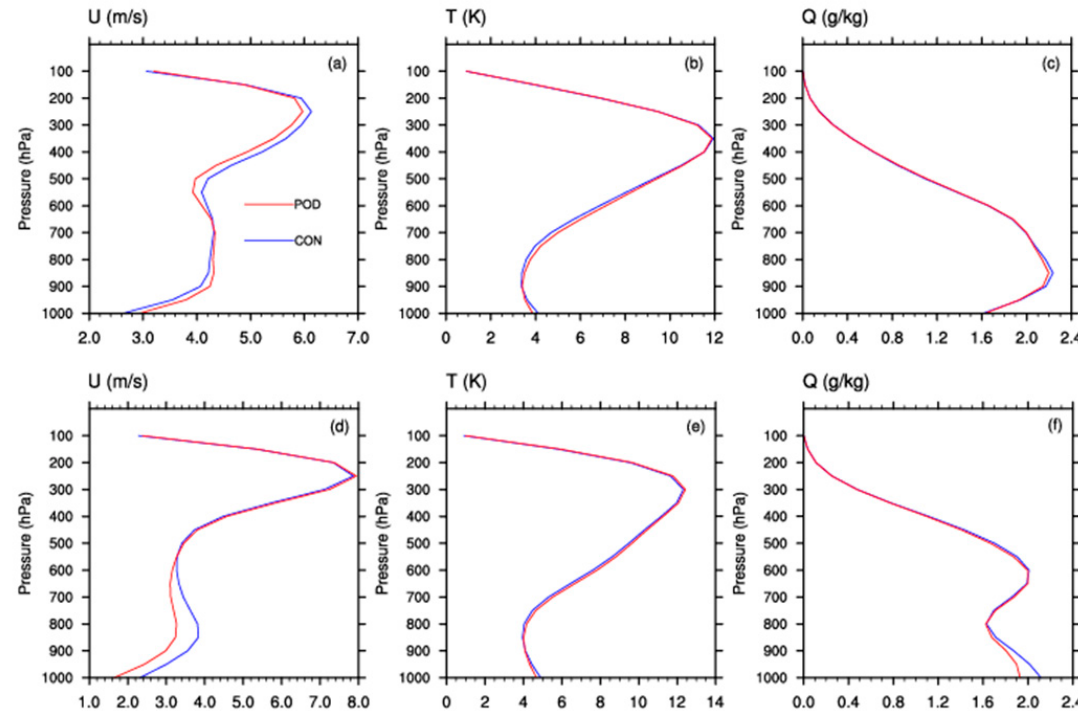
Figure 5. Vertical profiles of average RMSE of 24-h forecasts for horizontal wind, temperature, and water